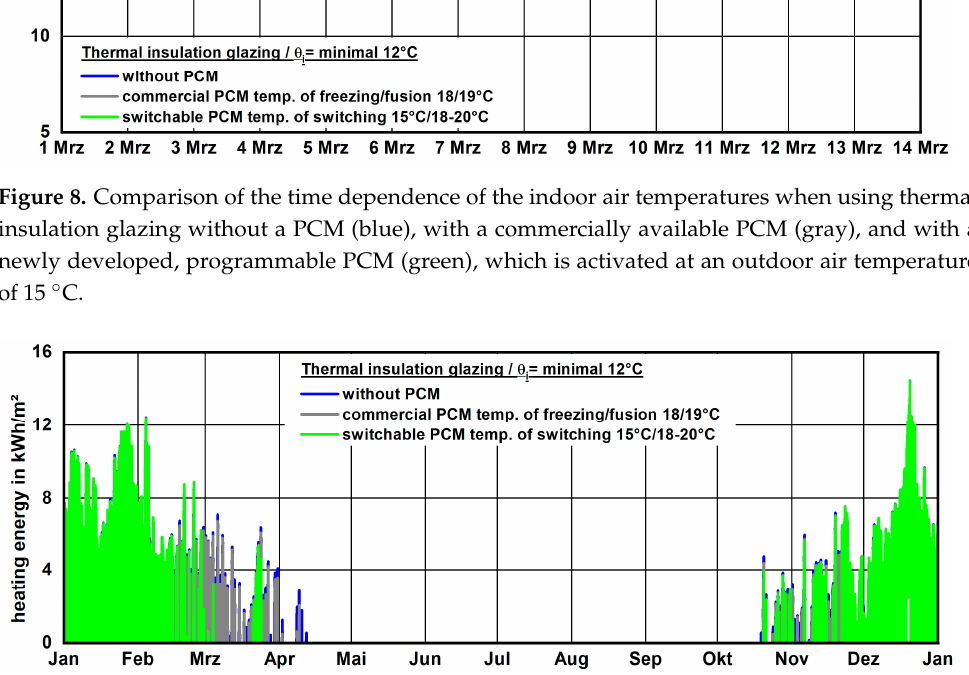
Figure 10. Comparison of the required heating energy for the period from 1 January to 21 April when using thermal insulation glazing without a PCM (blue), with a commercially available PCM (gray), and with a newly developed, programmable PCM (green). 4. Summary Within the framework of the research project Fraunhofer Cluster of Excellence “Pro- grammable Materials,” programmable phase change materials are being developed, which offer new possibilities for energy saving and temperature control due to their com- position and, in particular, the possibility of external (largely temperature-independent) activation of the phase change and the associated energy release. A possible application scenario was developed and presented by means of hygrothermal building simulations (WUFI ® Plus), based on the example of greenhouses. By integrating a programmable PCM, which is adapted to the application scenario, on the one hand, the risk of frost in the greenhouse can be reduced by activating the heat output, and, on the other hand, a sig- nificant reduction of the heating energy required to maintain a minimum temperature can be achieved. The main advantage of these heat storage systems in the considered applica- tion is that the storage tanks are recharged naturally by solar energy. Thus, the utilization and vegetation phase can be effectively optimized and extended without any additional heat source. In comparison to greenhouses with single glazing and thermal insulation glazing without heat storage, the calculation results show that the use of phase change materials can reduce the number of hours in which frost can occur in the greenhouse by up to 85%. Furthermore, the use of an optimized and programmable PCM can reduce the heating requirement by approximately 20% if the minimum temperature in the green- house does not drop below 12 °C. Due to the variety of material design options, further savings potential can be tapped in the future. One of the next steps is to implement the